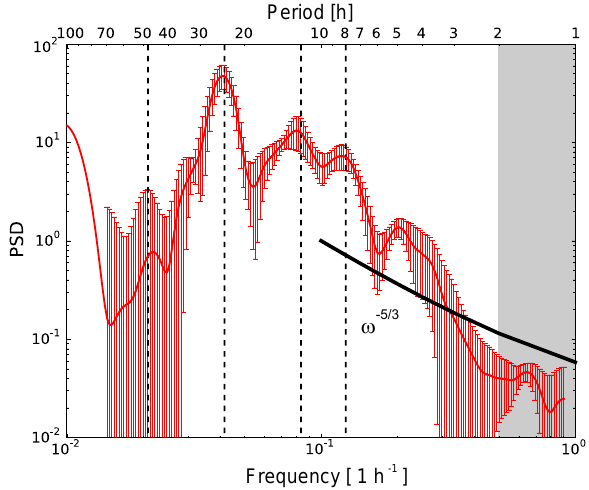
Figure 2. Smoothed power spectral density (PSD) as a function of frequency on 4–13 May 2016 calculated from the temperature de- viations from a mean at 50km altitude. The vertical dashed lines indicate periods of 8, 12, 24, and 48h. The error bars denote the standard deviation of the power spectral density calculated from spectra obtained during the first and the second half of the mea- surement and the spectra for the whole measurement. The grey box marks the region where the data contain less information due to the resolution limit given by the integration time of